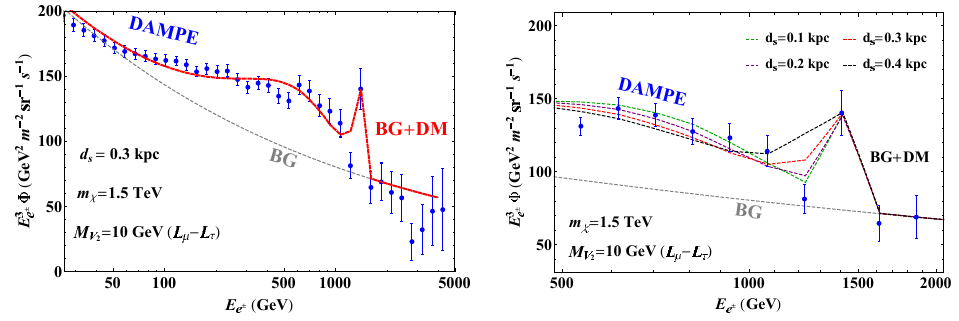
Figure 2 . Left panel: DAMPE electron energy spectrum. Overlaid is the sum of cosmic ray background and the electron (cid:13)ux from DM annihilations from the MW halo and from the nearby subhalo, which is d s = 0 : 3 kpc away from us. Right panel: same as the left panel except that we take di(cid:11)erent d s values: d s = 0 : 1 ; 0 : 2 ; 0 : 3 ; 0 : 4 kpc. Here V 1 is electrophilic and V 2 is L (cid:22) (cid:0) L (cid:28)